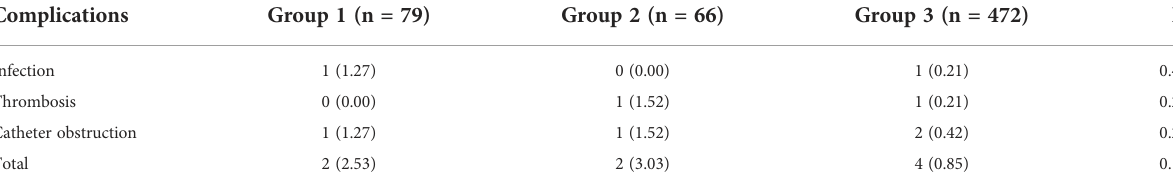
TABLE 3 Comparison of incidence of TIVAP-related complications among the three